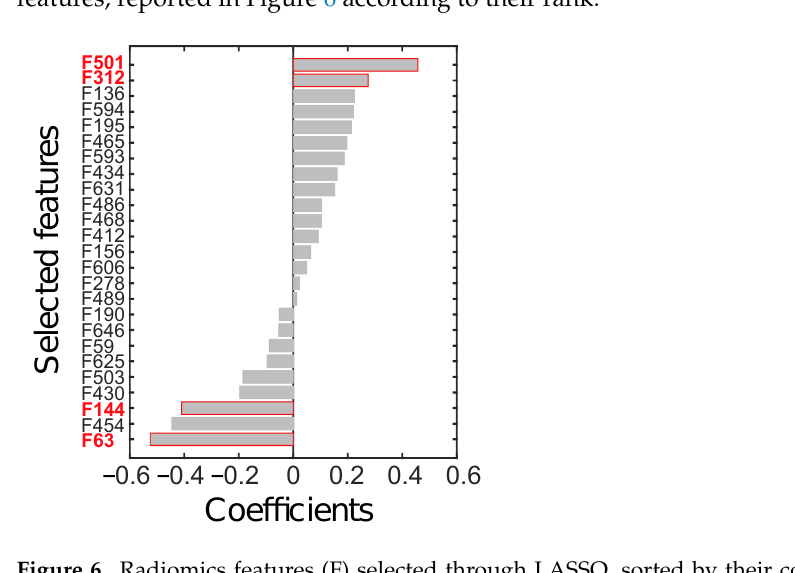
Figure 6. Radiomics features (F) selected through LASSO, sorted by their coefficients. The four features in red text colour (i.e., F63, F144, F312, and F501) are the ones finally selected to constitute the radiomics signature.